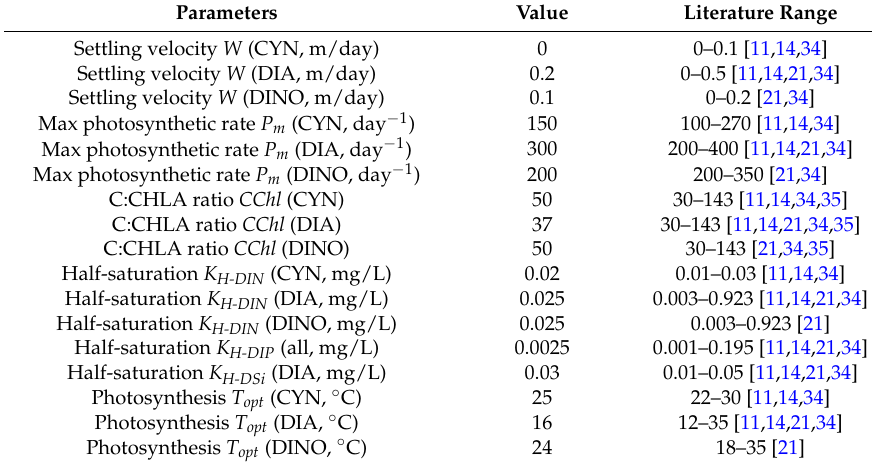
Figure 2. Schematic flow diagram of ICM set up for Chesapeake Bay. LDOC, RDOC, LPOC, RPOC, labile/refractory dissolved/particulate organic carbon; LDON, RDON, LPON, RPON, labile/refractory dissolved/particulate organic nitrogen; LDOP, RDOP, LPOP, RPOP, labile/refractory dissolved/particulate organic phosphorus; PSi/DSi, particulate/dissolved silica; COD, chemical oxygen demand; DO, dissolved oxygen; NO23, nitrite and nitrate; NH4, ammonia; PO4, phosphate; DIN, dissolved inorganic nitrogen. Table 1. Key kinetic parameters used for the ICM for Chesapeake Bay. CHLA, chlorophyll = a. Parameters Value Literature